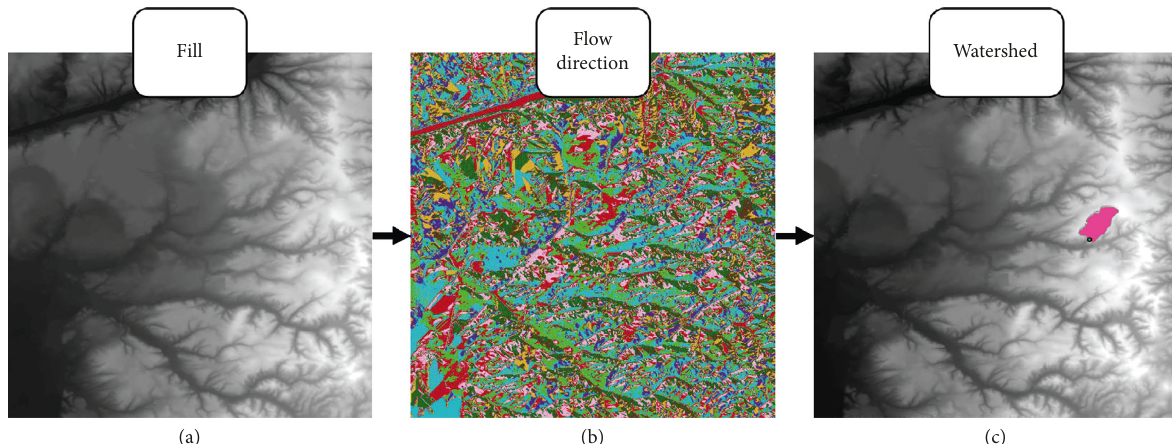
Figure 3: Progression of watershed delineation outputs: (a) fill, (b) flow direction, and (c) delineated watershed